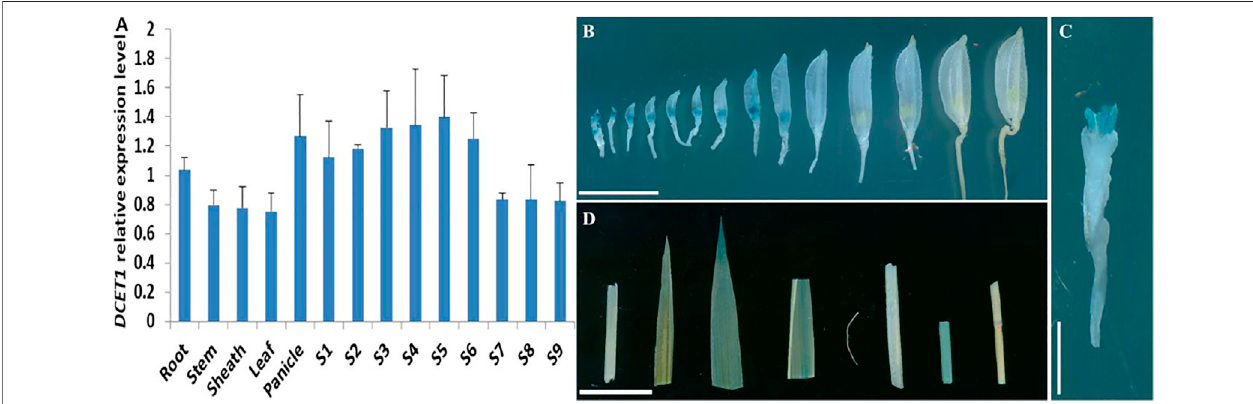
FIGURE 11 | Expression analysis of DCET1 . QPCR relative expression level at different developmental stages of spikelets (on length basis) and other plant tissues (A) . S1 – S10 anthers dissected from fl orets with 2 – 3 mm, 3 – 4 mm, 4 – 5 mm, 5 – 6 mm, 6 – 7 mm, 7 – 8 mm, 8 – 9 mm, 9 – 10 mm, > 10 mm; GUS-staining of the proDCET1 :